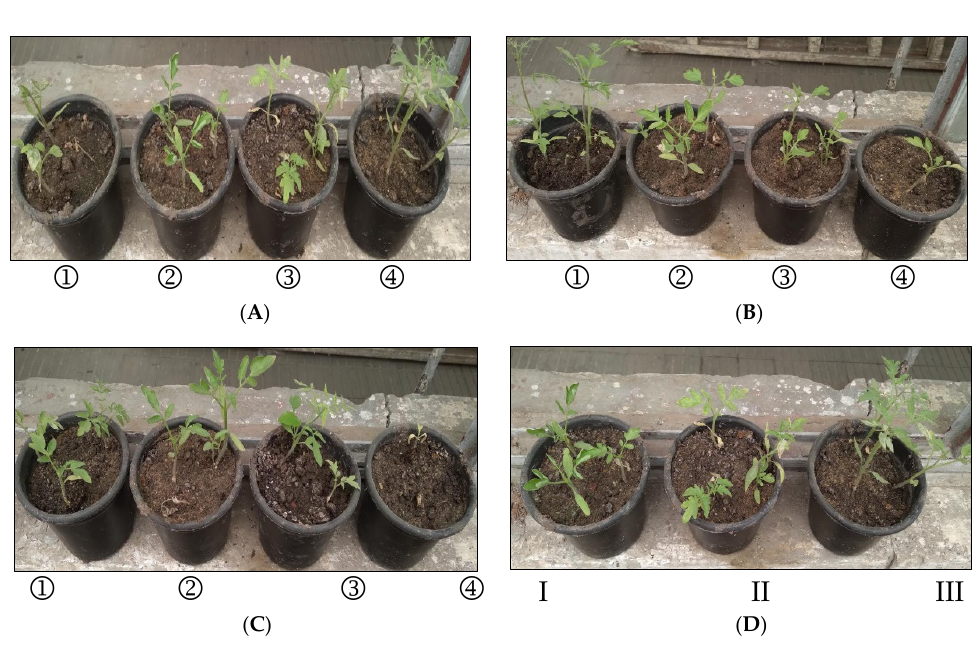
Figure 2. Effect of disinfectant agents at different concentrations and atrio 80% on the incidence of tomato root rots caused by S. rolfsii at 35 DAP (greenhouse conditions). ( A ) Formulated phenol (7%); ( B ) chloroxylenol (10%); ( C ) phenic (10%); ( D ) ( I ) Atrio (80%); ( II ) control pathogen; ( III ) healthy control. 1 (cid:13) 125 µ L 100 mL − 1 ; 2 (cid:13) 250 µ L 100 mL − 1 ; 3 (cid:13) 500 µ L 100 mL − 1 ; 4 (cid:13) 1000 µ L 100 mL − 1